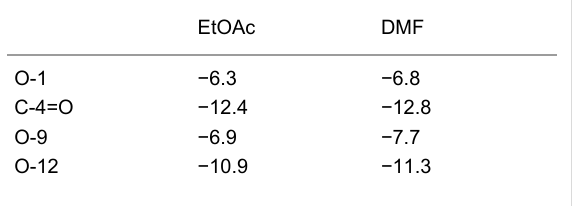
Table 3: Electronic energies ( Δ E , kcal·mol − 1 ) of BF 3 complexation with silybin A ( 1a ) at the different